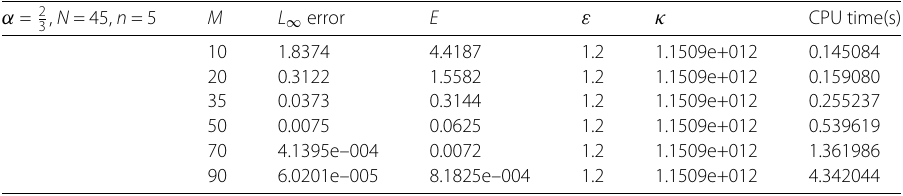
Table 2 The maximum absolute error, shape parameter, condition number and computational time corresponding to Problem 2 at t = 1 α = 2 , N = 45, n = 5 M L ∞ error ε κ 3